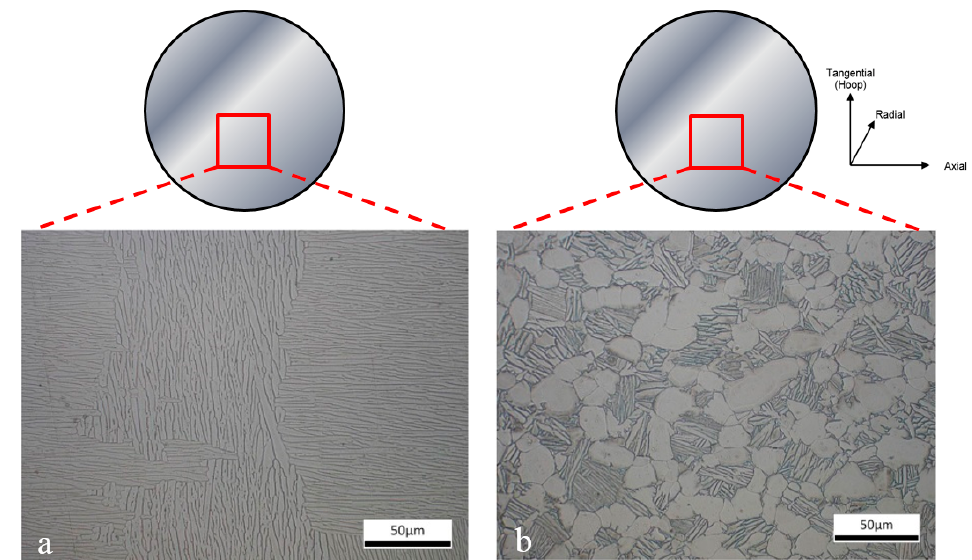
Figure 3. Microstructure of ( a ) Cast and HIP Ti-6Al-4V and ( b ) Forged Ti-6Al-4V small punch disc specimens prior to testing, illustrating the top surface of the SP specimen where the punch makes initial contact.